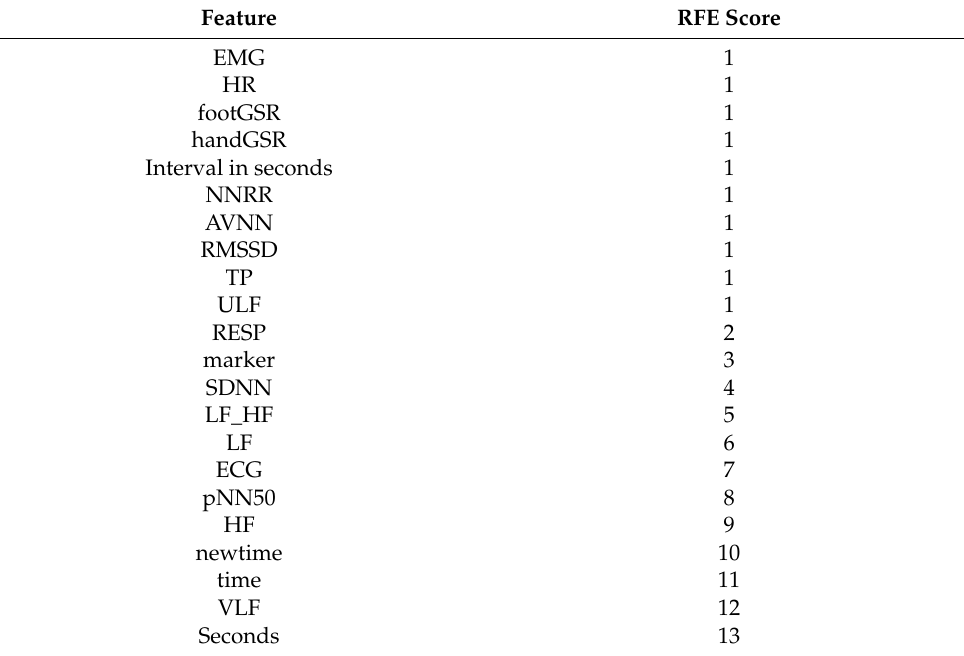
Table 2. RFE feature importance score on original-dataset, the most relevant features have the lowest RFE score.